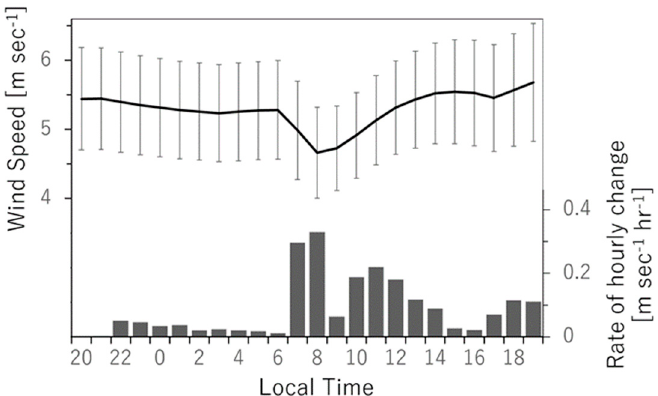
Figure 3. Diurnal cycle of area-averaged annual means of hourly 100m-height onshore wind speeds (black solid line) obtained from the mean of ensemble members. Error bars and black bars represent the range of standard deviation among the ensemble members and magnitude of the hourly change of the wind speed, respectively. The hourly changes are computed by the previous hour subtracted from the current hour.